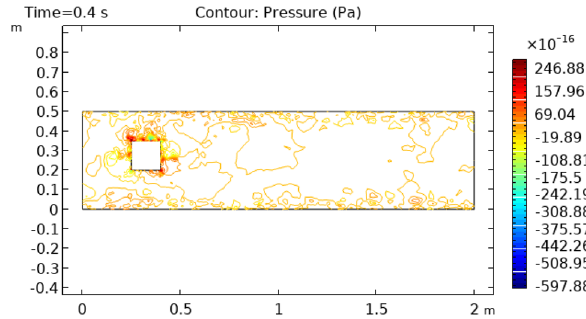
Figure 6. Pressure distribution in squared cylindrical flow at t = 0.4 s.